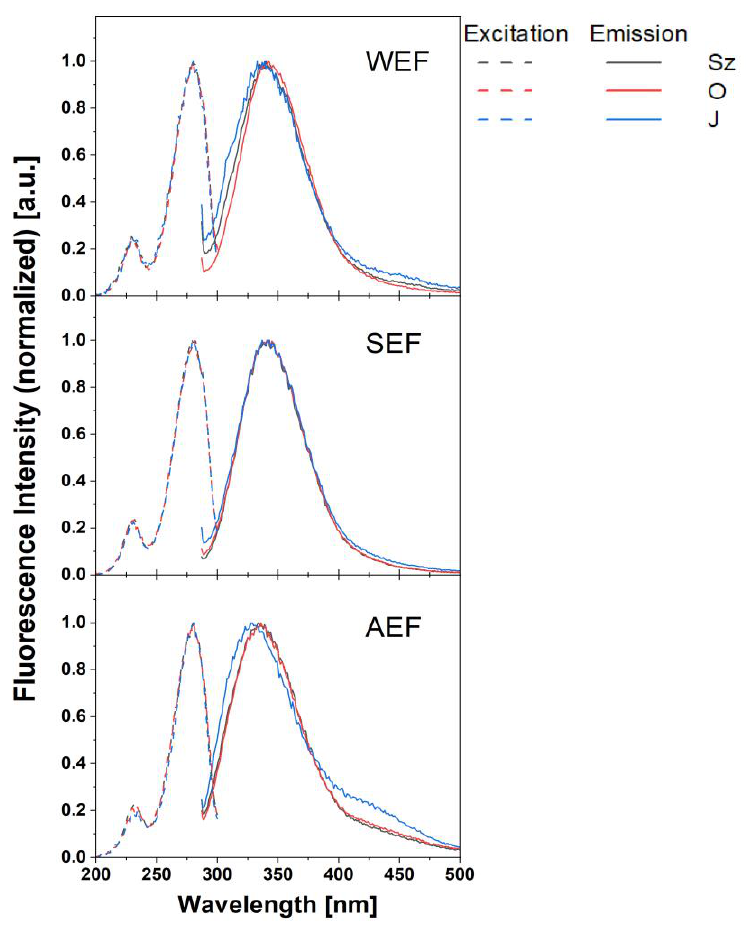
Figure 4. Fluorescence spectra of the flaxseed protein fractions. WEF—water-extracted fraction; SEF—salt-extracted fraction; AEF—alkaline-extracted fraction; Szafir (Sz), Oliwin (O) and Jantarol (J) cultivars; solid lines: emission, dot: excitation.